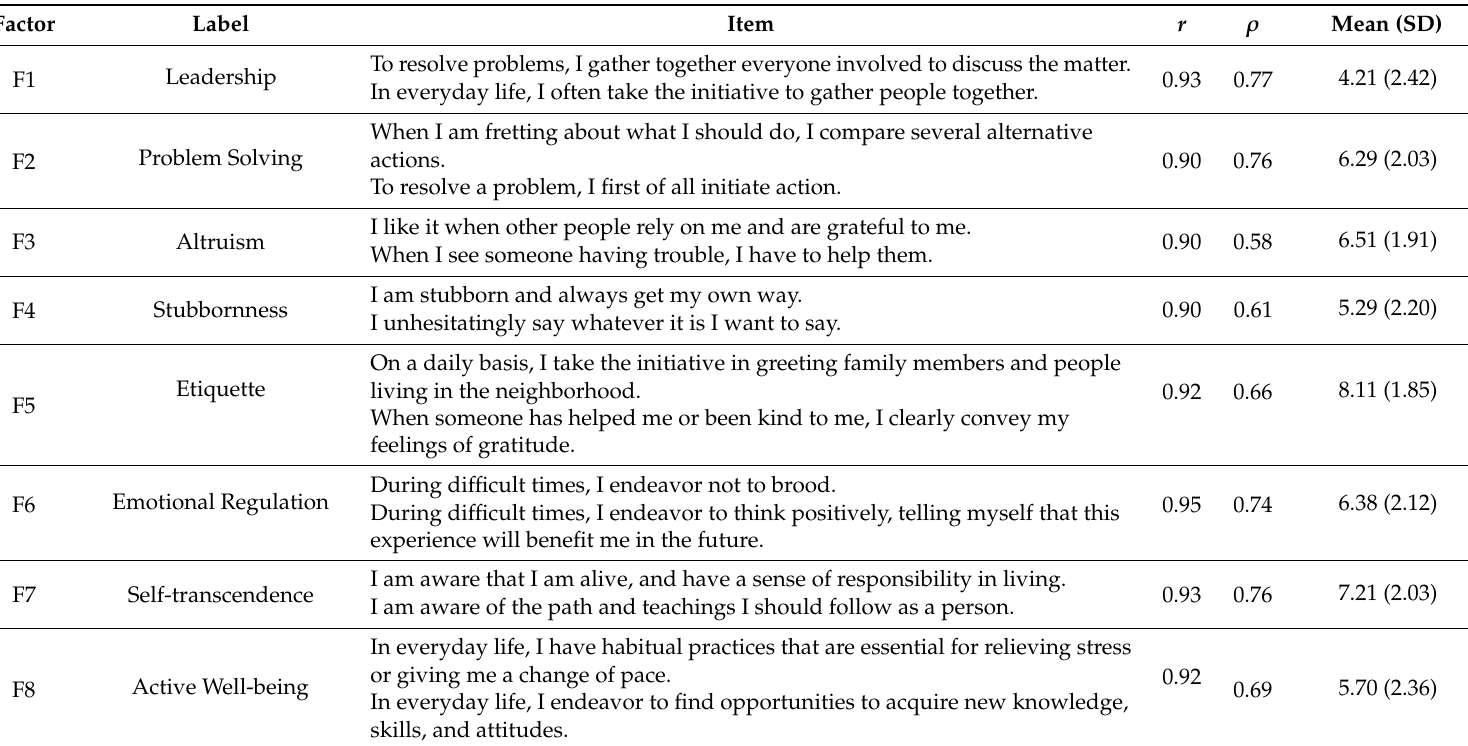
Table 1. Means and standard deviations (SDs) of selected items with each factor, and their reliability indices.